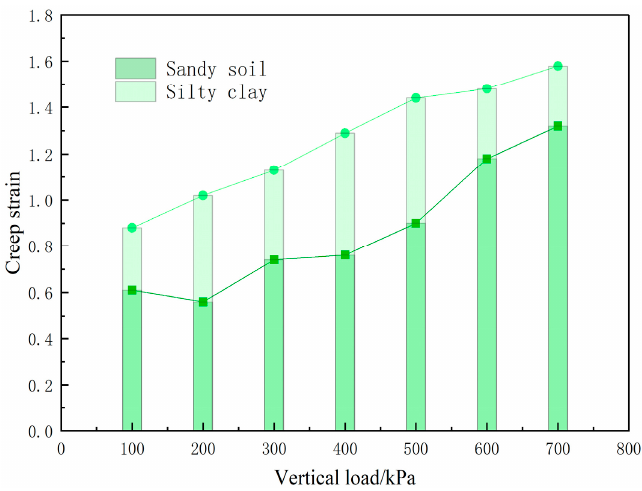
Figure 6. The stress – creep strain relationship curve of soil samples. From the analysis above, it can be drawn that when the vertical load is less than 500 kPa, the creep process of soil samples shows transient deformation, decelerated creep, and constant creep, which reflects the viscoelastic and viscoplastic characteristics of the sandy soil and silty clay. When the vertical load is added to 500 kPa, transient deformation, decelerated creep, constant creep, and accelerated creep stages have occurred in the creep process, which reflects the nonlinear viscoelastic-plastic characteristics. In addition, in the consolidation creep test of sandy soil and silty clay in Changsha, the time of the completion of the primary consolidation is about 1 h, and then the transition to the creep stage of slow